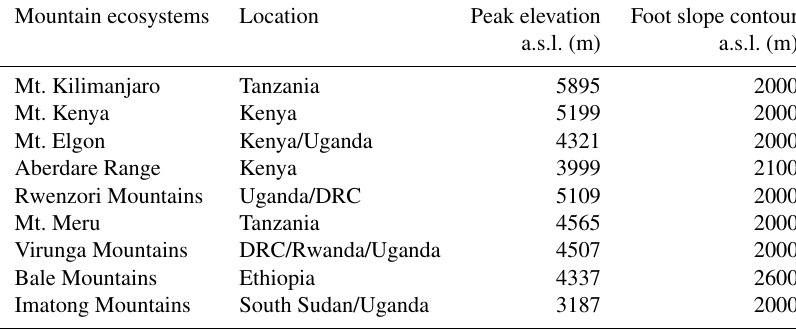
Table 1. The selected water towers of East Africa. Note: a.s.l. – above sea level.